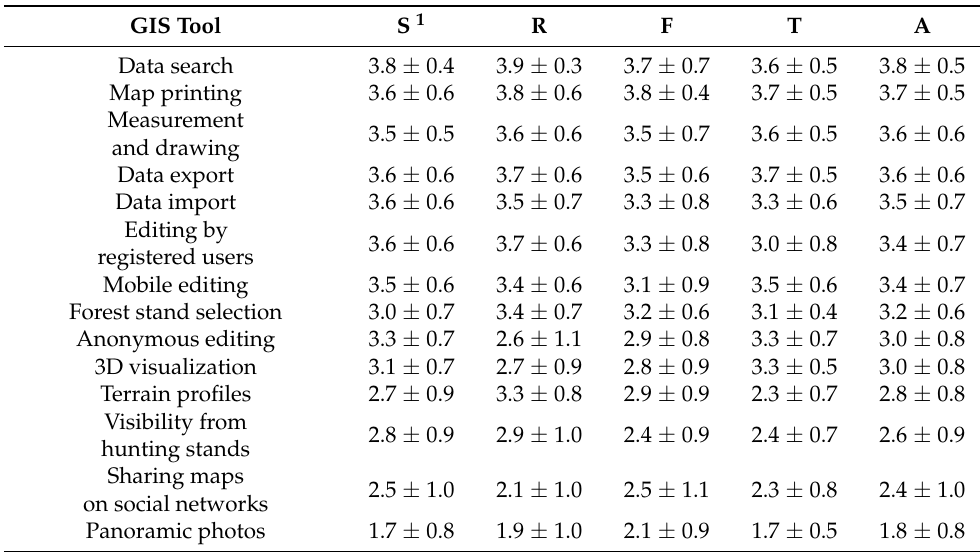
Table A7. Importance of GIS tools.